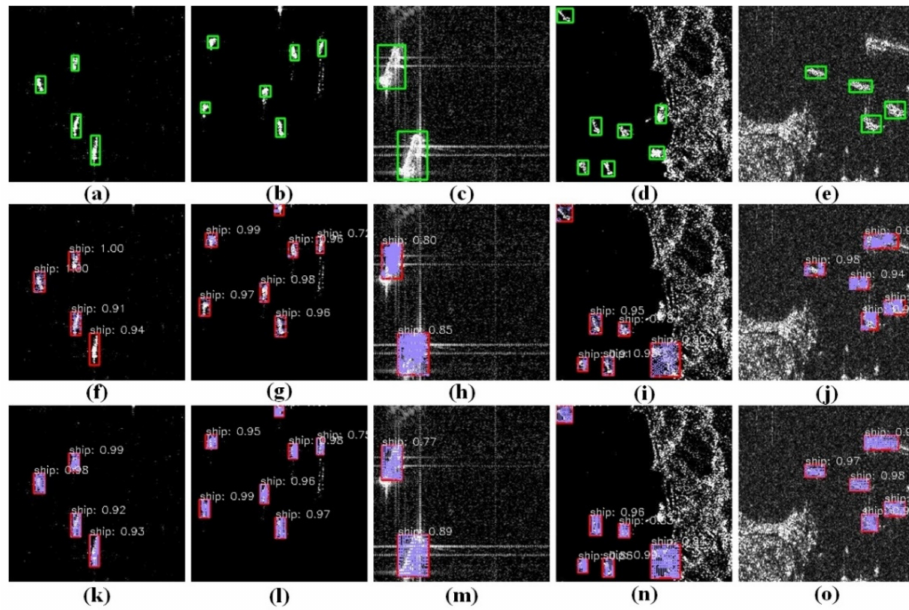
Figure 14. Object detection results and instance segmentation results. ( a – e ) The top row contains ground truth images. ( f – j ) The middle row contains the results of Case 3. ( k – o ) The bottom row contains the results of Case 4.